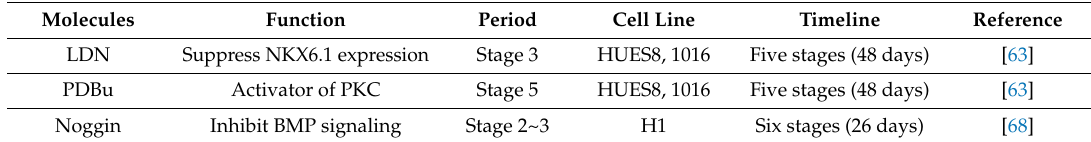
Table 2. Molecules that promote the maturation of α -cells.